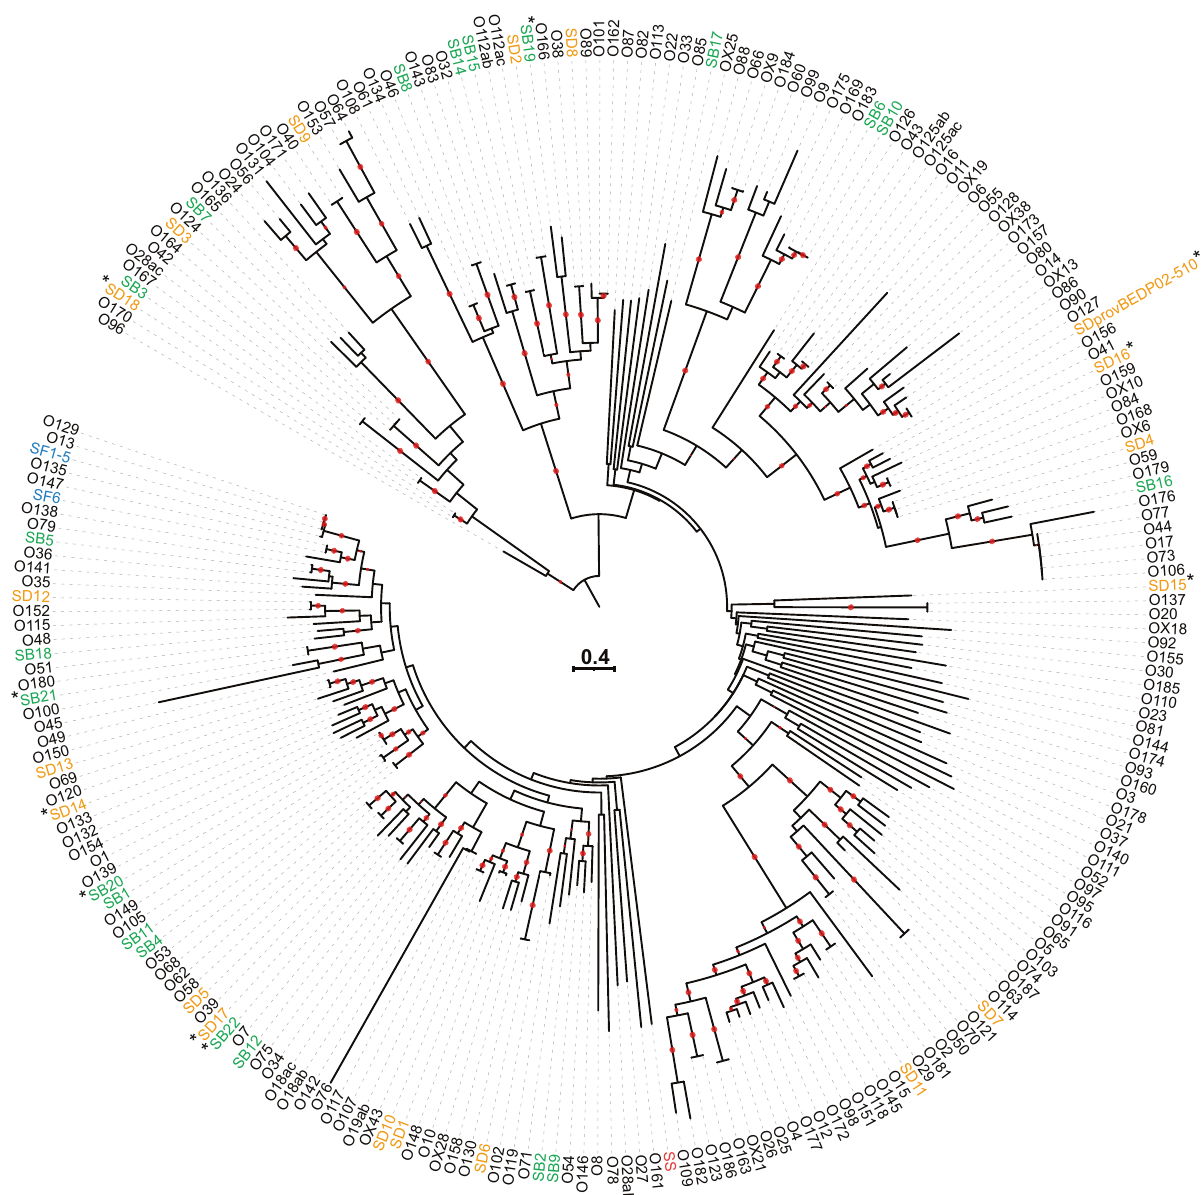
Fig. 7 Phylogenetic tree for all Shigella and E. coli O-antigen gene clusters. The Shigella O-antigen gene clusters ( rfb ) characterised in this study are indicated by an asterisk. Nodes supported by bootstrap values ≥ 95% are indicated by red dots. S. boydii rfb genes are shown in green, S . dysenteriae rfb genes are shown in orange, S. fl exneri rfb genes are shown in blue, and S. sonnei rfb genes are shown in red. The scale bar indicates the number of nucleotide substitutions per variable